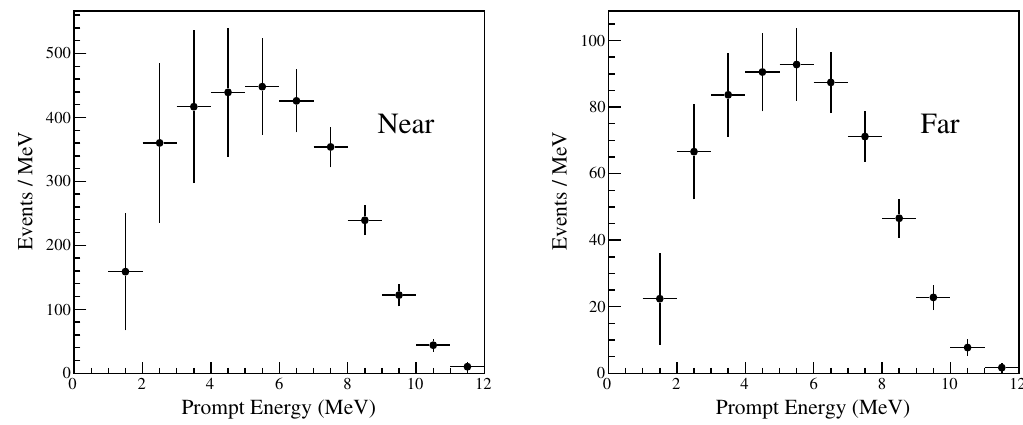
Figure 12 . Measured prompt energy spectra of 9 Li/ 8 He background using their enriched samples of 2000 live days, after subtracting the IBD signal and the muon-induced accidental background. The error bars represent the statistical error of the enriched sample and the (cid:12)t uncertainty of delayed time distribution.